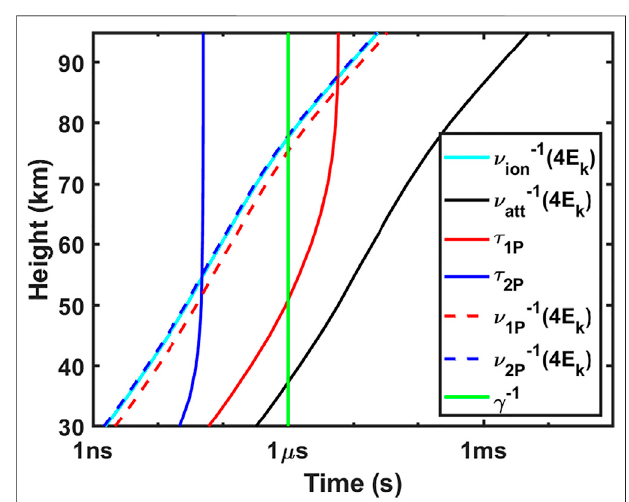
FIGURE 2 | The characteristic time coef fi cient for calculating sprite emissions are compared in units of seconds at different altitudes. The characteristic time scales versus altitude where these time coef fi cients represent the ionization rate (cyan solid line) ] ion − 1 , the excitation rate − 1 for N ] Π g state (red dashed line) at 4 E k , the excitation rate 1P 2 B 3 C 3 Π u state (blue dashed line) at 4 E k , the lifetime τ 1P of N 2 1P (red solid line), and the lifetime τ 2P of 2P band (blue solid line) emissions. The lifetimes of the N 2 1P and 2P bands tend to be shorter due to the higher quenching rates (i.e.,de-excitation processes)withincreasedneutraldensityatloweraltitudes. The characteristic time for electron attachment rate ] att − 1 at 4 E k (black solid line) indicates the lifetime of streamer body where accumulated electrons at the streamer body are dissipated away after impact ionization by high electric fi eldatthestreamerhead.Thecharacteristictime( γ − 1 forthegreenline)forthe growth rate γ in a sprite streamer is almost